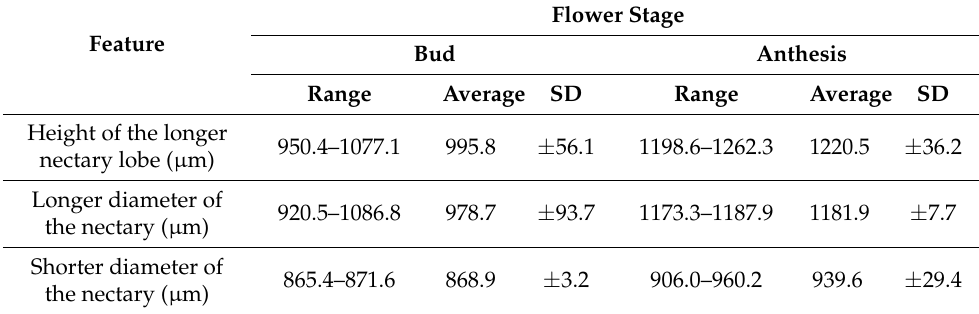
Table 1. Measurements of the Dracophalum moldavica